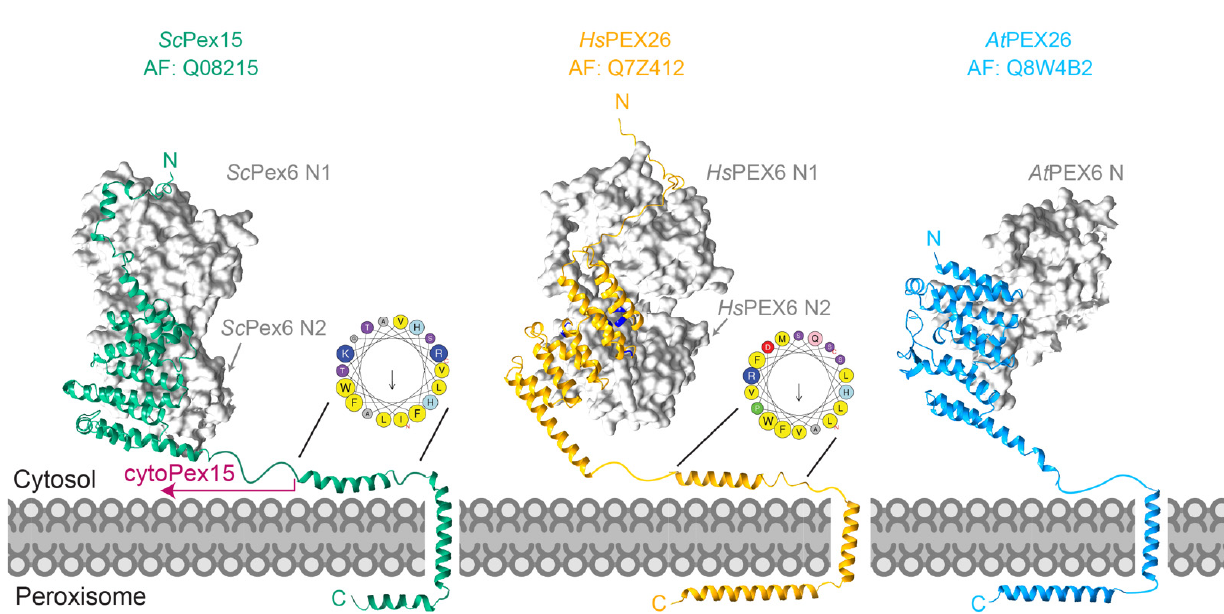
Figure 5. Structural models for the Pex1/Pex6 peroxisomal tethers: S. cerevisiae Pex15, H. sapiens PEX26, and A. thalania PEX26, based AlphaFold2 multimer predictions. Pathogenic missense muta- tions in PEX26 (D43H, L44P, L45P, G89R, R98W, P117L, and P118R) are colored in blue (Leiden Open Variation Database 3.0, [199]). Predictions for transmembrane domains are from the highest scores from TMHMM-2.0 [200]. Helical wheels generated in Heliquest [201], letters indicate predicted protein